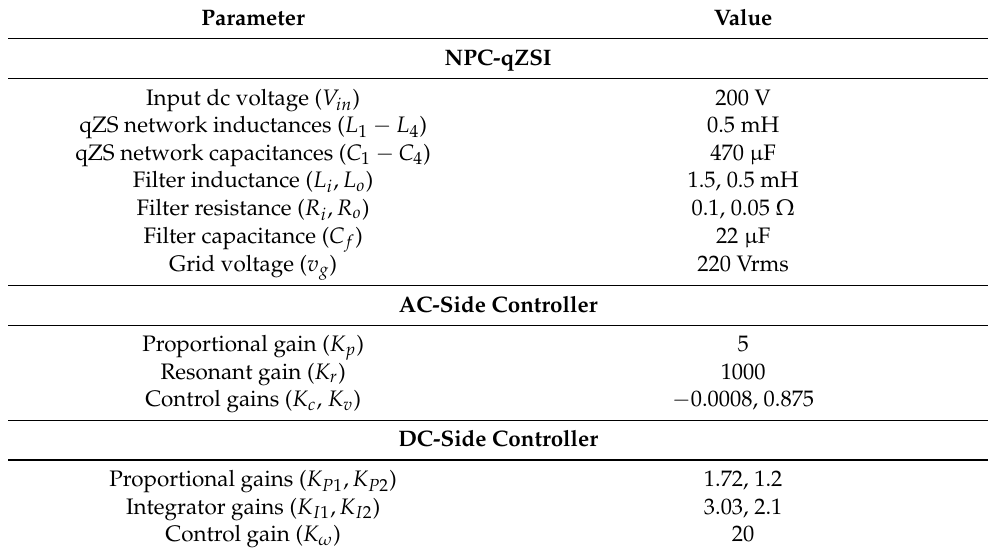
Table 1. System and Control Parameters.